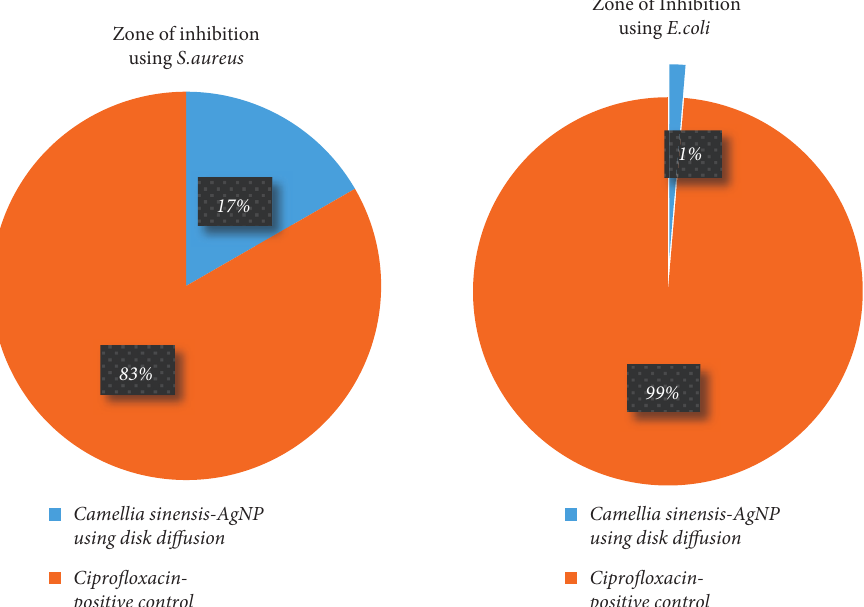
Figure 6: The zone of inhibition obtained against Staphylococcus aureus and Escherichia coli illustrated in the pie